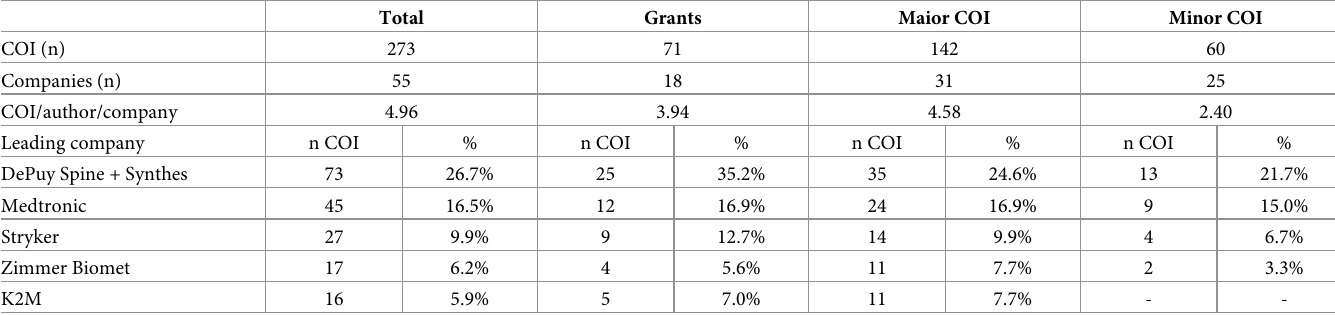
Table 3. Leading companies involved in the different COIs during the period